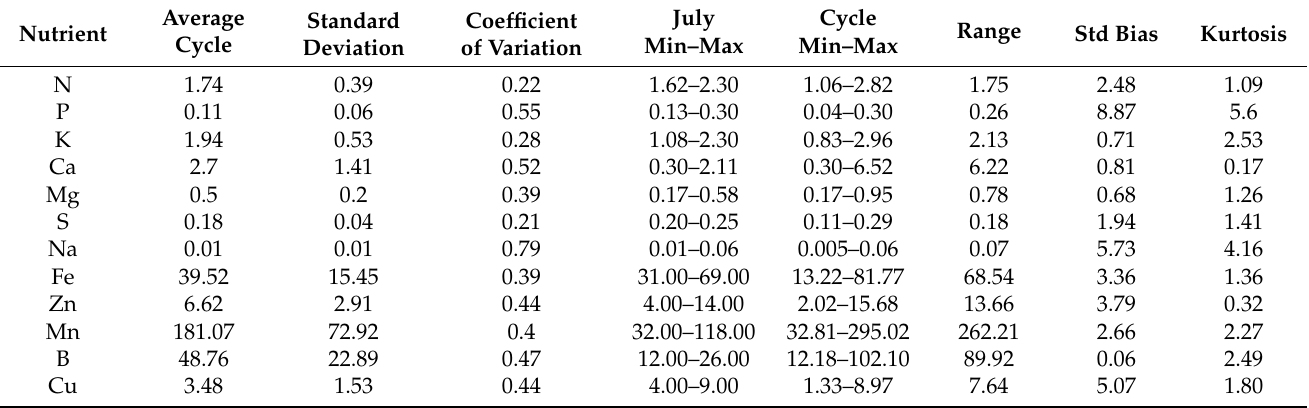
Table 2. Ionomic analysis of the persimmon leaves. Concentrations are expressed in g/100 g for macronutrients (N, P, K, Ca, Mg, S and Na) and mg/kg for micronutrients (Fe, Zn, Mn, B and Cu) based on the weight of dry